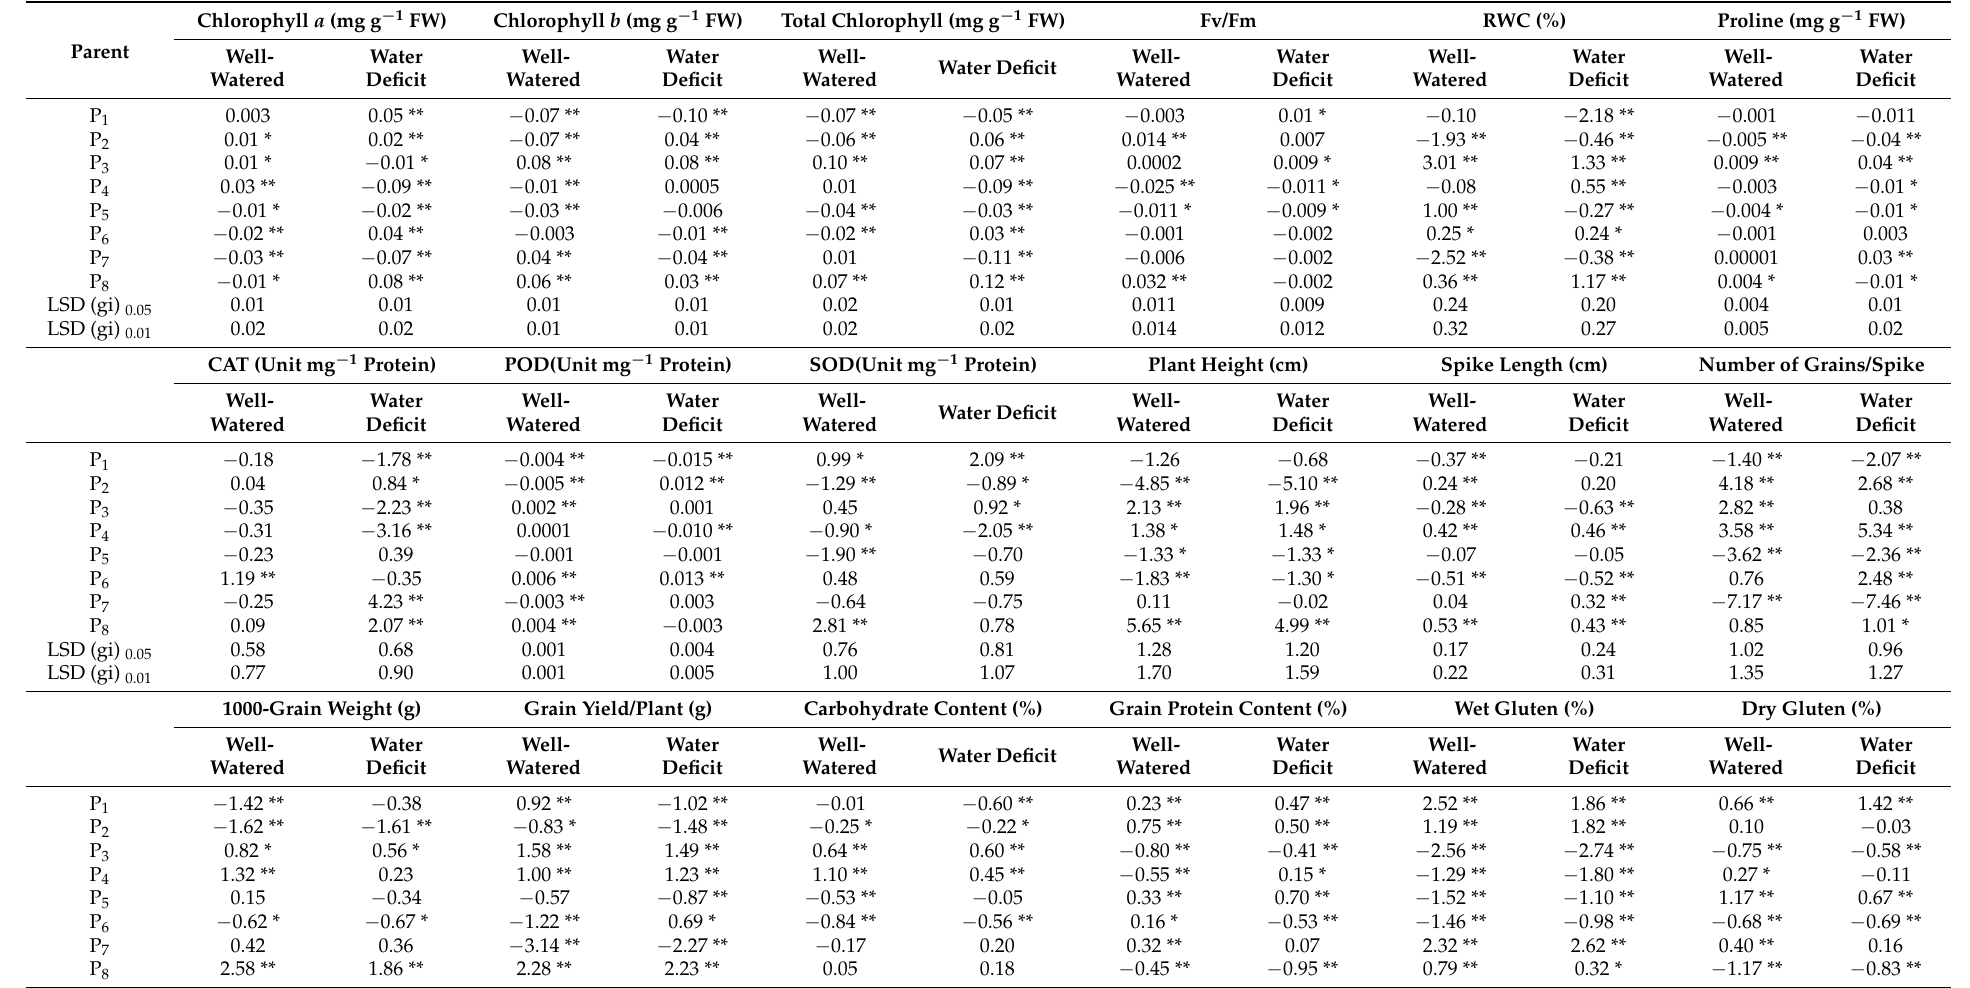
Table 2. General combining ability estimates (GCA) of the eight parents for all assessed traits under well-watered and drought stress